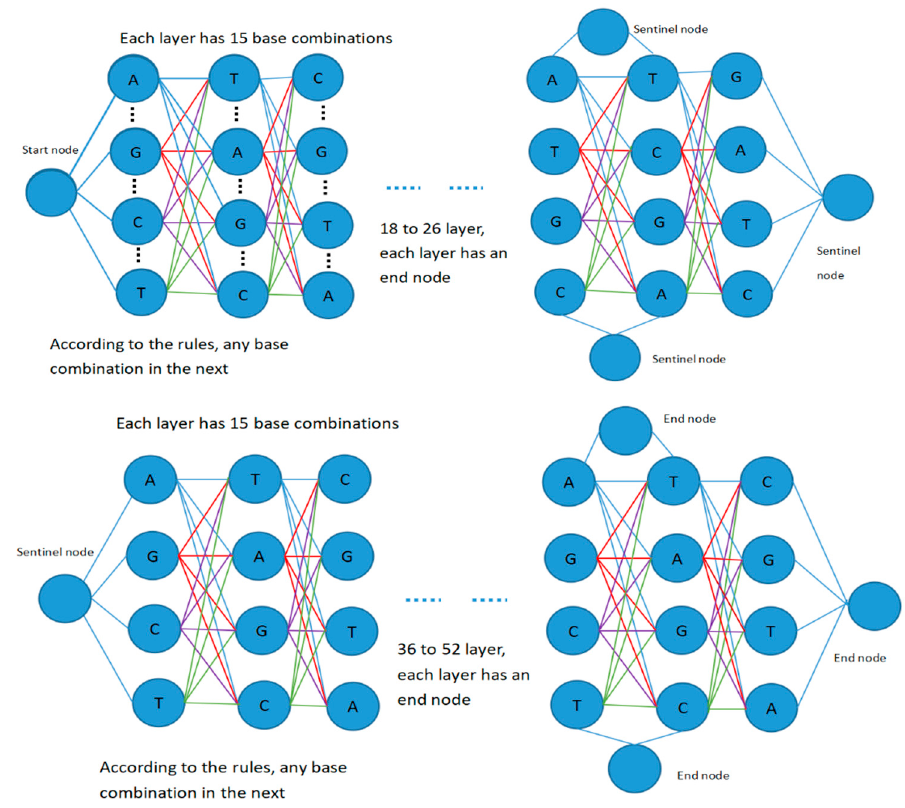
Figure 3. Representation of the search space.